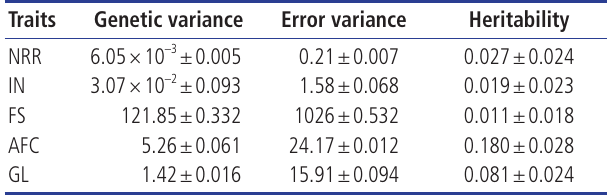
Table 4. Genetic parameters (±standard error) of heifer reproductive traits